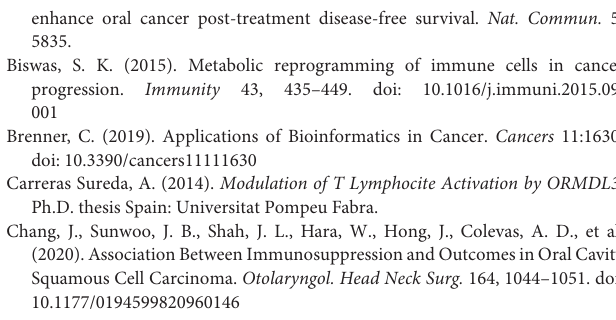
Supplementary Table 12 | The model performance comparison between Deep learning-based model with the PCA-based model. Supplementary Table 13 | The all DEGs dysregulated between the two subtypes of OSCC samples, ranked by the ascending order of p -value. Supplementary Table 14 | The topological characteristics of the nodes in the ISGs-DEGs related PPI network. The listed nodes in this table include the top 20 ISGs-upregulated DEGs, top 20 ISGs-downregulated DEGs, and top 20